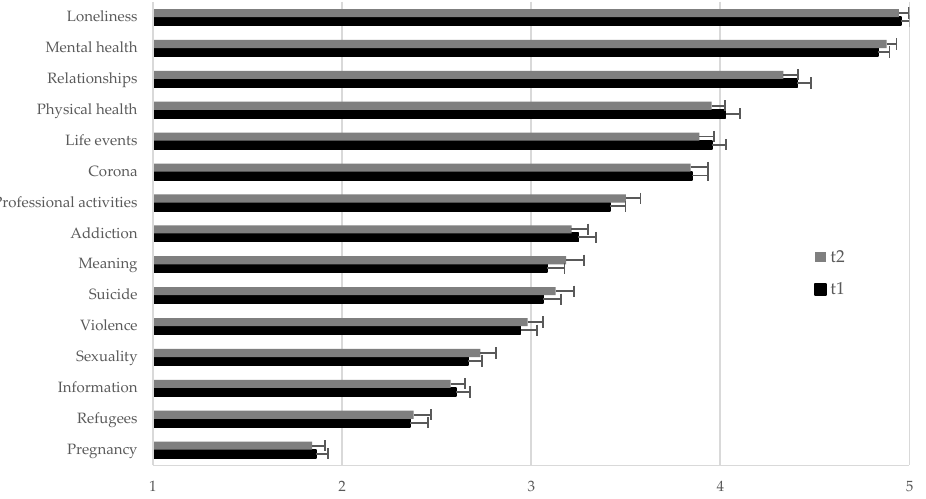
Figure 1. Counselors’ rating of the frequency of topics thematized by helpline callers during winter 2020/2021 (t1) vs. during winter 2021/2022 in Austria (t2) (N = 108). Note: counselors rated the frequency of each topic on a six-point scale from 1 = “never” to 6 = “always”. Data are shown as least squares means (LSM) ± standard error of the means.